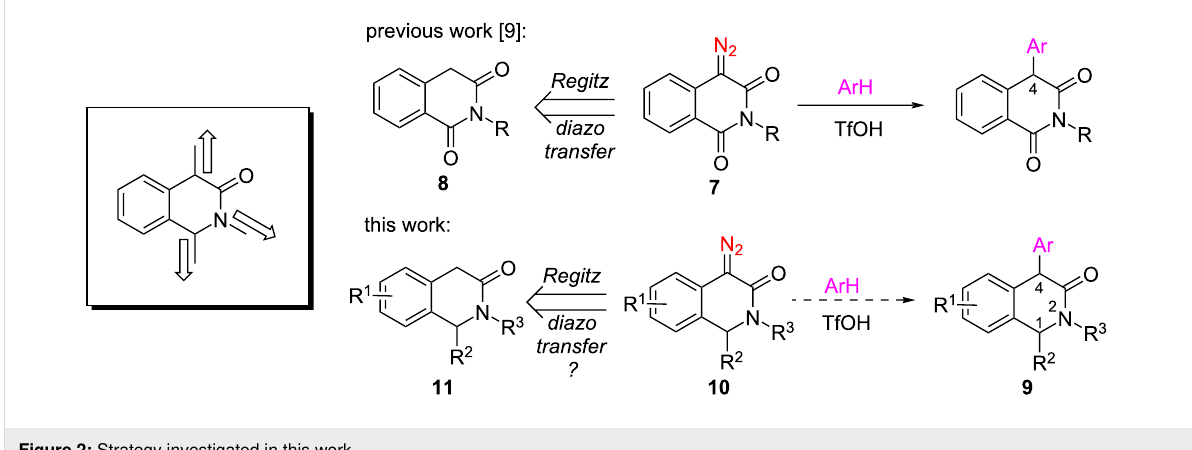
Figure 2: Strategy investigated in this work.